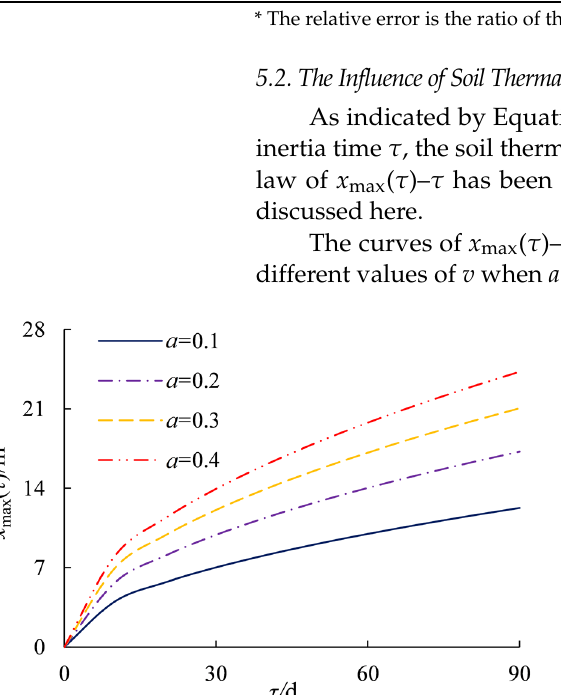
Figure 8. Curves of x max ( τ )– τ under different values of a and v .